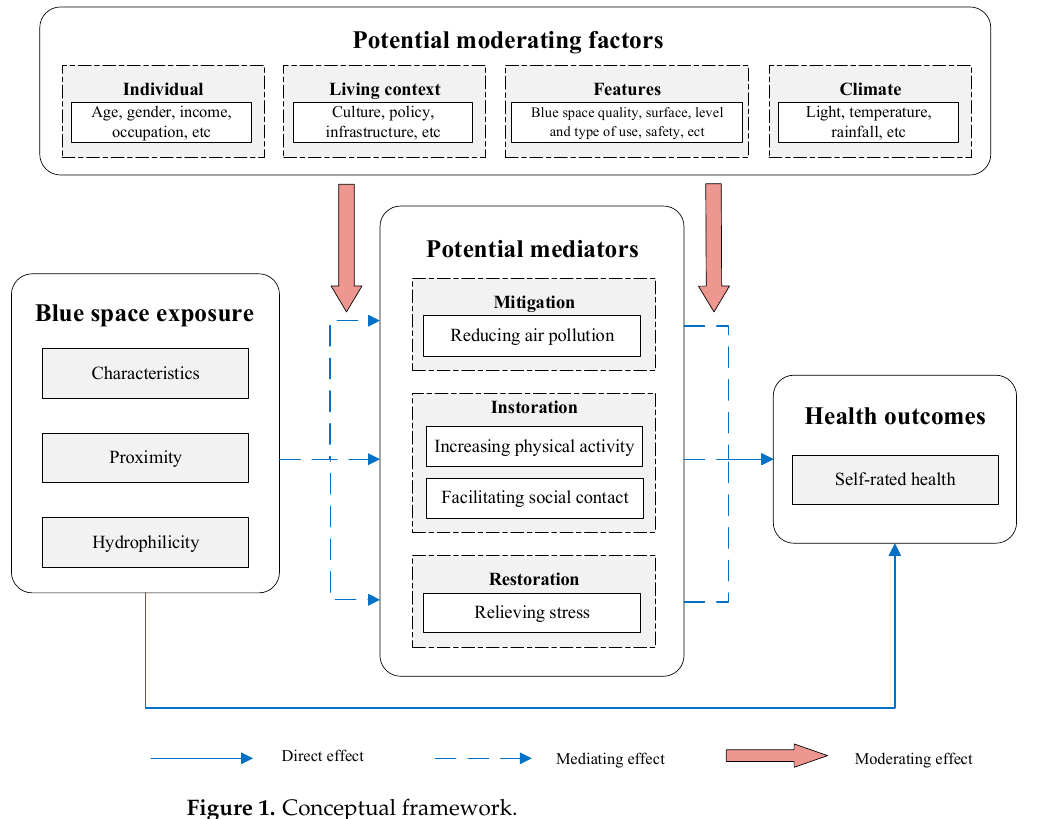
Figure 1. Conceptual framework.